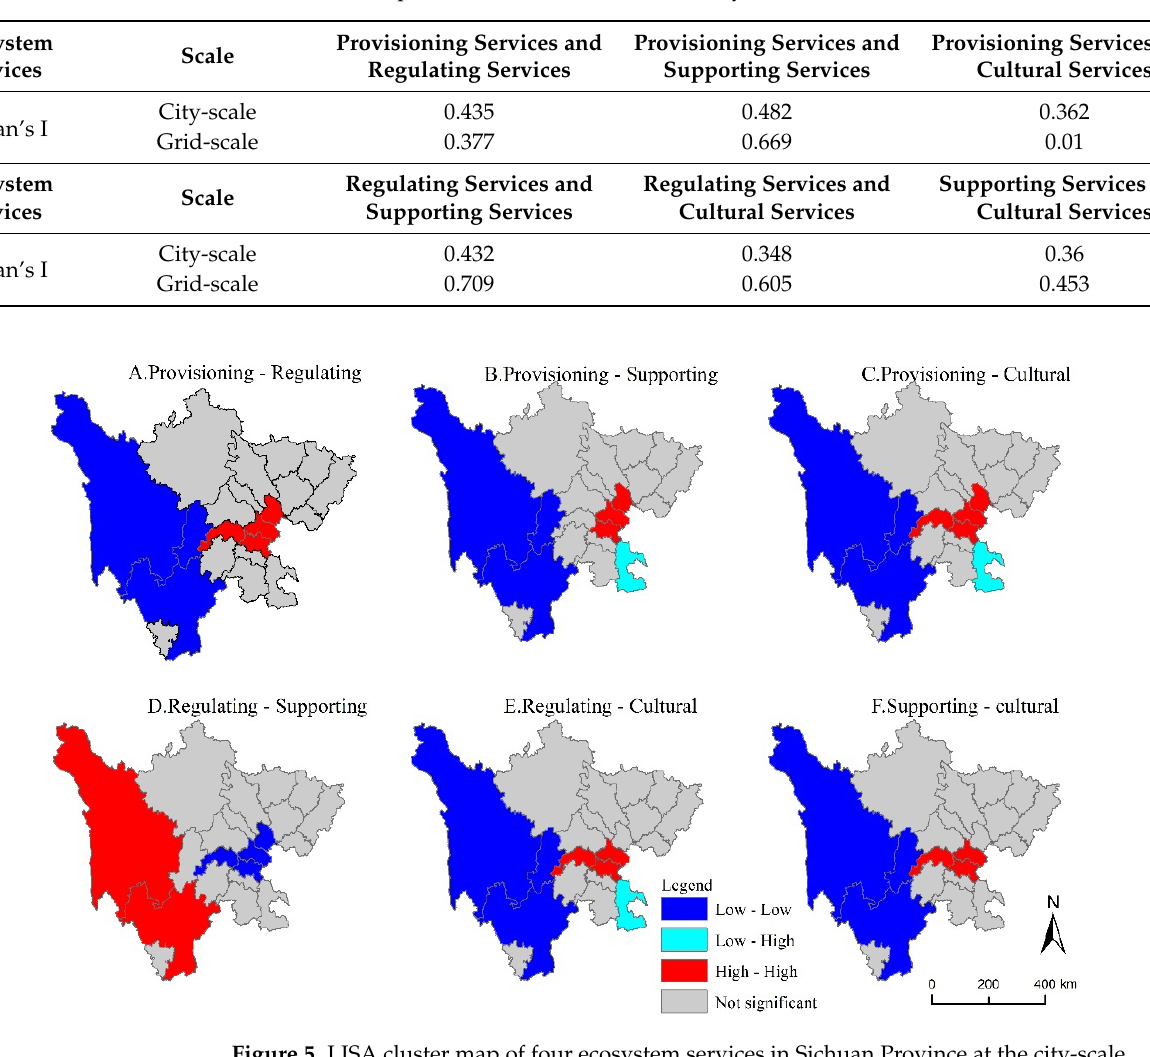
Table 6. Global spatial autocorrelation of four ecosystem services in Sichuan Province.